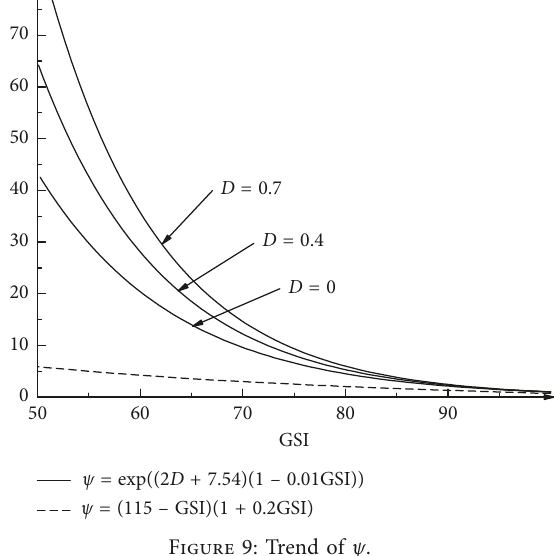
Figure 7: Approximation of η